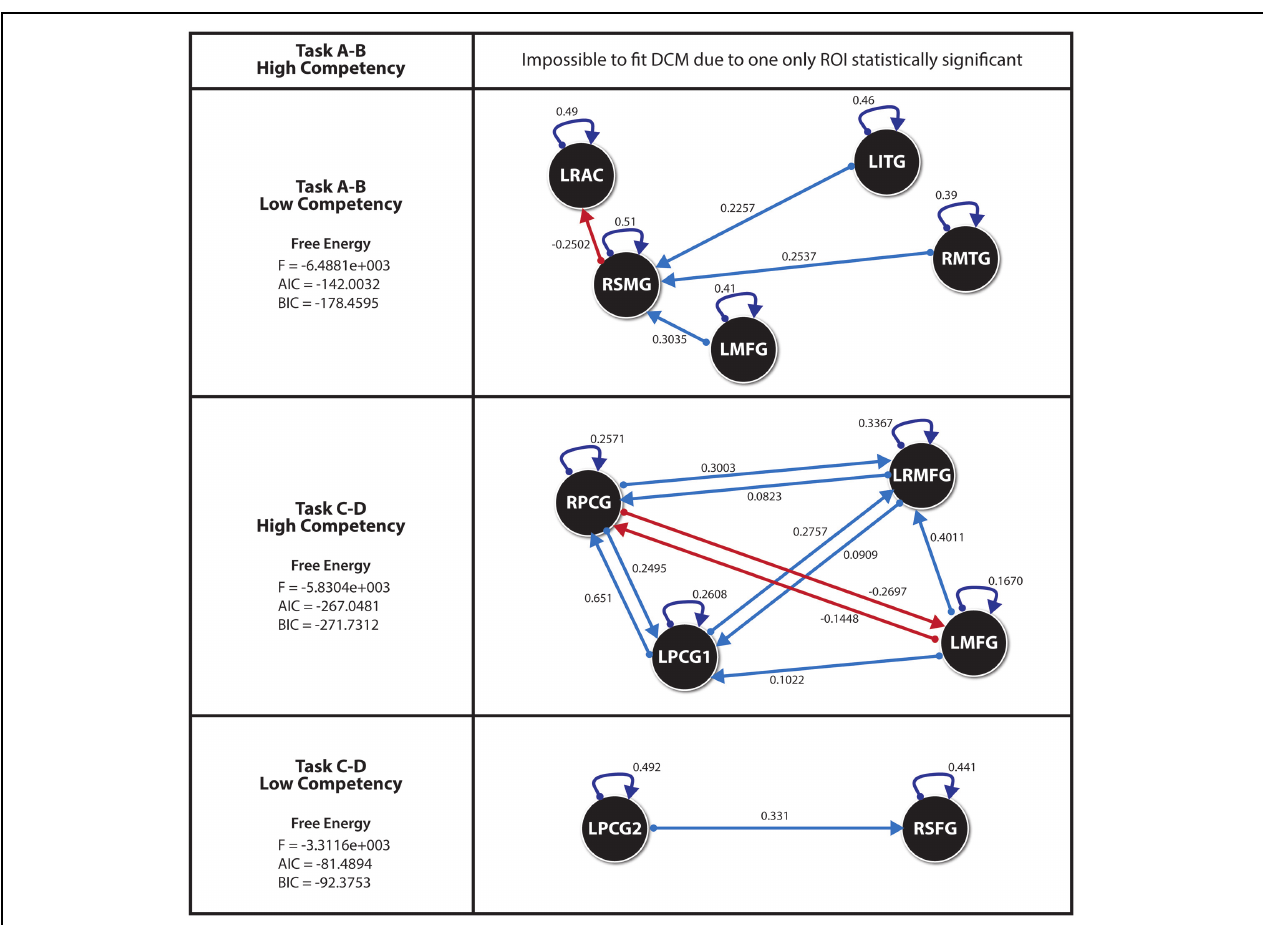
FIGURE 4 | Effects for each DCM with the parameter values for each significant direct effect. All effects p < 0.05. ROI’s for Spelling recognition Task. LITG (Left Inferior Temporal Gyrus), RMTG (Right Middle Temporal Gyrus), LMFG (Left Middle Frontal Gyurs), RSMG (Right Supramarginal Gyrus), LRAC (Left–Right Anterior Cingulate). ROI’s for